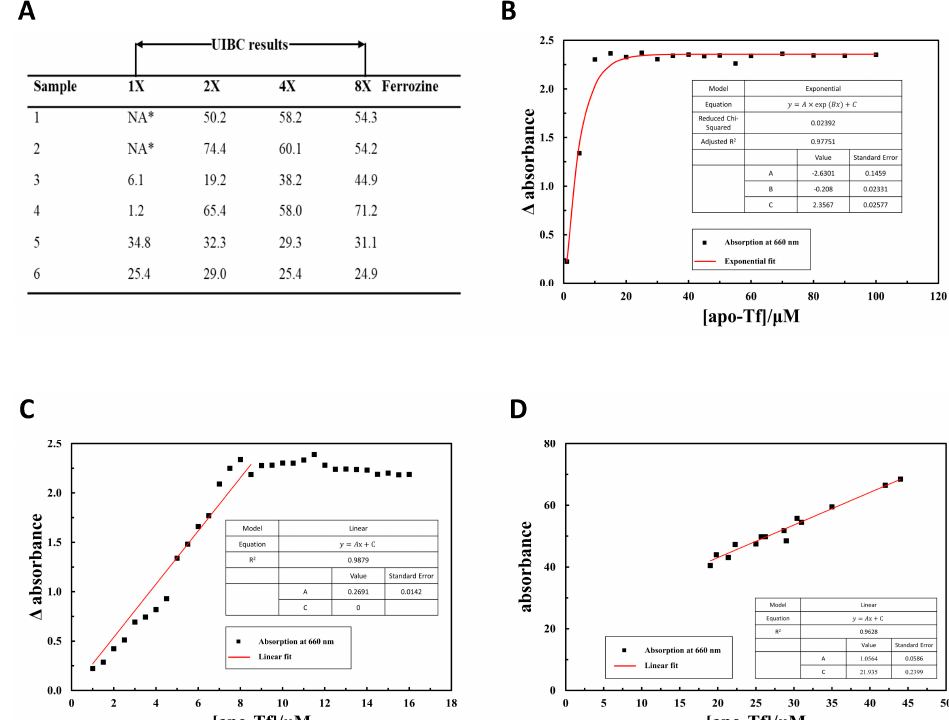
Figure 1. MTC assay. ( A ) Inconsistency in UIBC at low readings. A 0.04 mL volume of 7.8 mM ferrozine was used in the standard UIBC test (1 × ). Additionally, up to 8-fold levels of ferrozine were used in the comparative study. UIBC results were derived by UIBC ( µ mol/L) = 89 ( µ mol/L Iron added) − Excess Iron ( µ mol/L). NA* indicates for a negative result. ( B ) The graph of absorbance at 660 nm against the concentration of apo-Tf in Tris-HCL solution, using MTC as the probe. The graph follows an exponential fit shown as y = A × exp ( Bx ) + C , where y is the absorbance at 660 nm, x is the concentration of apo-Tf, A = − 2.63, B = − 0.21 and C = 2.36. The graph shows a potential linear correlation for apo-Tf under 10 µ M concentration. ( C ) The graph of absorbance at 660 nm against the concentration of apo-Tf in Tris-HCL solution, using MTC as the probe, for apo-Tf concentration ranging from 0 to 16 µ M. The graph shows a linear correlation between 1 to 8 µ M shown as y = Ax + C , where y is the absorbance at 660 nm, x is the concentration of apo-Tf, A = 0.27, C = 0. ( D ) The graph of absorbance at 660 nm against the concentration of apo-Tf in plasma sample diluted 50 times, using MTC as the probe. The data on the graph follow a linear correlation shown as y = Ax + C where y is the absorbance at 660 nm, x is the concentration of apo-Tf, A = 0.022, C =